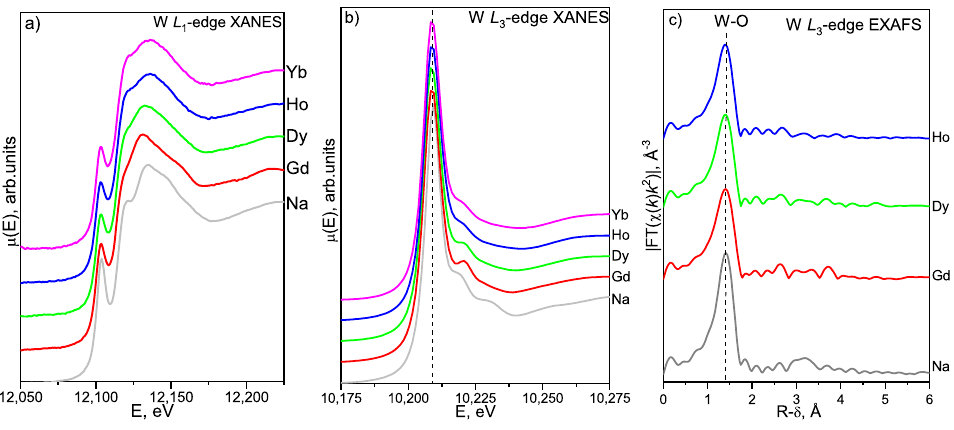
Figure 5. W L 1 -( a ) and L 3 -edge ( b ) XANES spectra and W L 3 -edge EXAFS FT moduli ( c ) of hydrated Ln WO-1000-1.5y powders and Na 2 WO 4 · 2H 2 O (reference